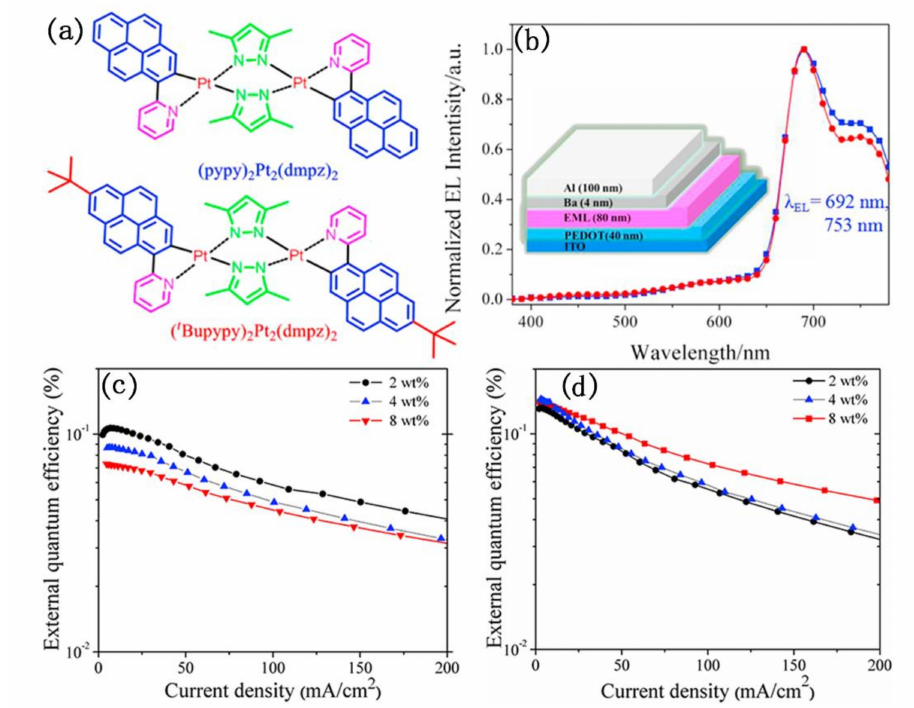
Figure 13. ( a ) The structure of (pypy) 2 Pt 2 (dmpz) 2 and ( t Bupypy) 2 Pt 2 (dmpz) 2 ; ( b ) electroluminescent (EL) spectra of the of (pypy) 2 Pt 2 (dmpz) 2 and ( t Bupypy) 2 Pt 2 (dmpz) 2 -based devices. Inset: The diagram of the EL devices; ( c , d ) are the external quantum efficiency (EQE) curves of the (pypy) 2 Pt 2 (dmpz) 2 - and ( t Bupypy) 2 Pt 2 (dmpz) 2 -based devices at different dopant concentrations from 2 wt% to 8 wt%. Reprinted from [81], Copyright 2016, with permission from